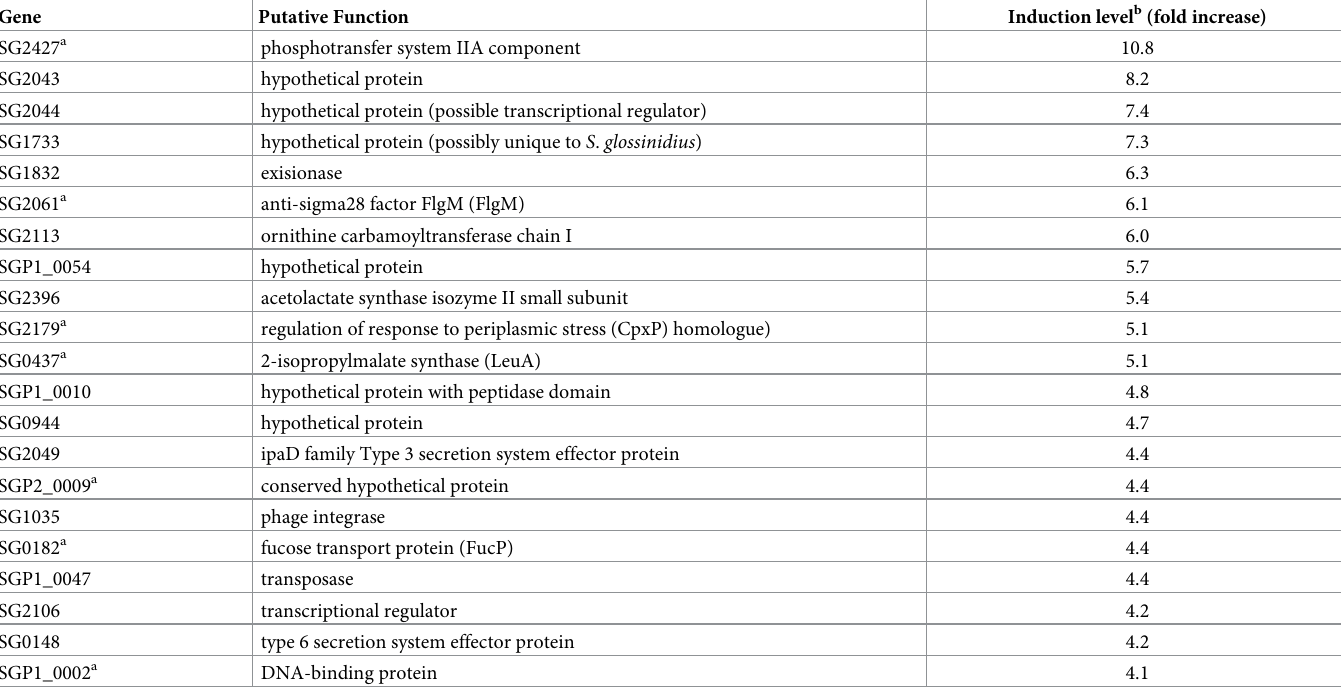
Table 2. Sgm heme-induced genes (top